Question: State the chart type depicted above.
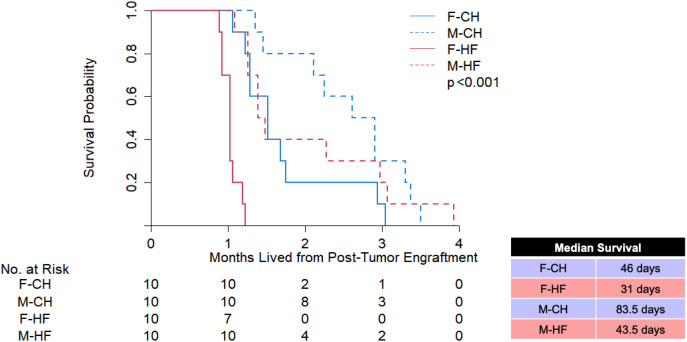
Answer: survival